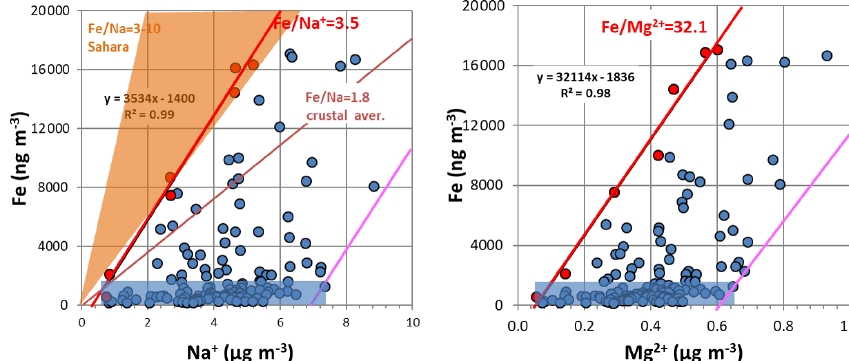
Figure 2. Edge lines (in red) for Fe versus Na + and Fe versus Mg 2 + intercomparisons. The blue rectangle represents periods without significant dust intrusions. The pink lines are parallels to the red edge lines in the maximum ion concentration regions. Also shown are Fe / Na ratio ranges in Sahara and global soils, for total sodium, taken from Moreno et al. (2006) and Mason and Moore (1982). Edge lines are best-fit linear lines traced through points in